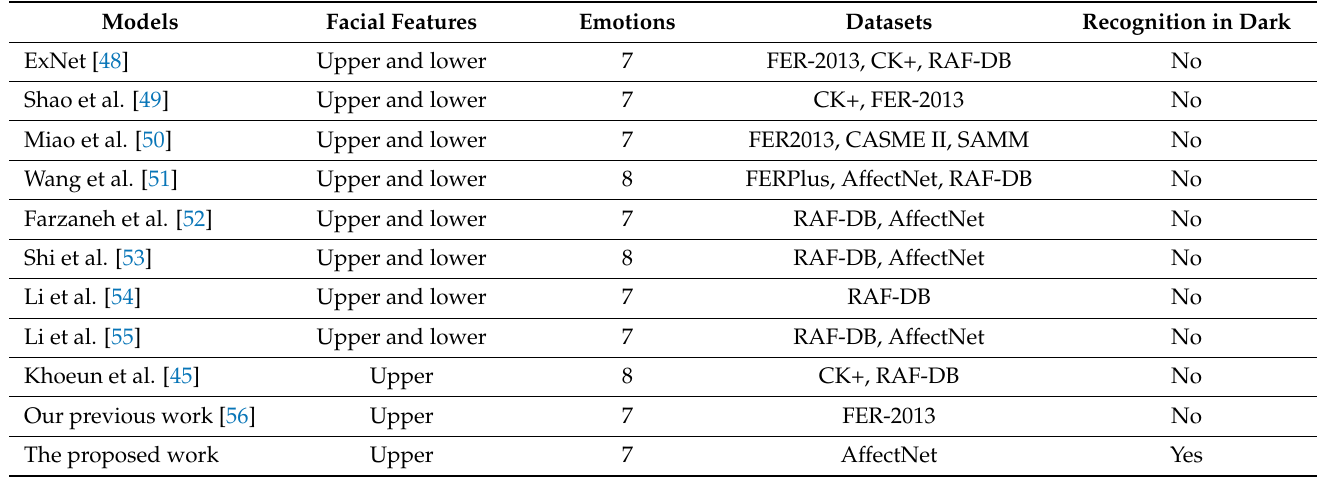
Table 1. The comparison of existing facial emotion recognition methods.